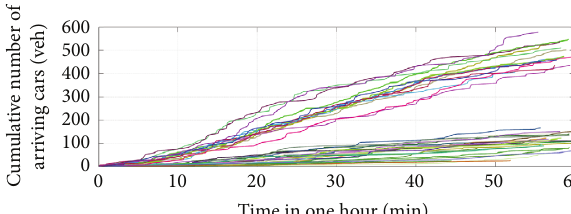
Figure 8: Observed arrival profiles for low-flow case (the lines with different colors represent the different samples of arrivals we observed).